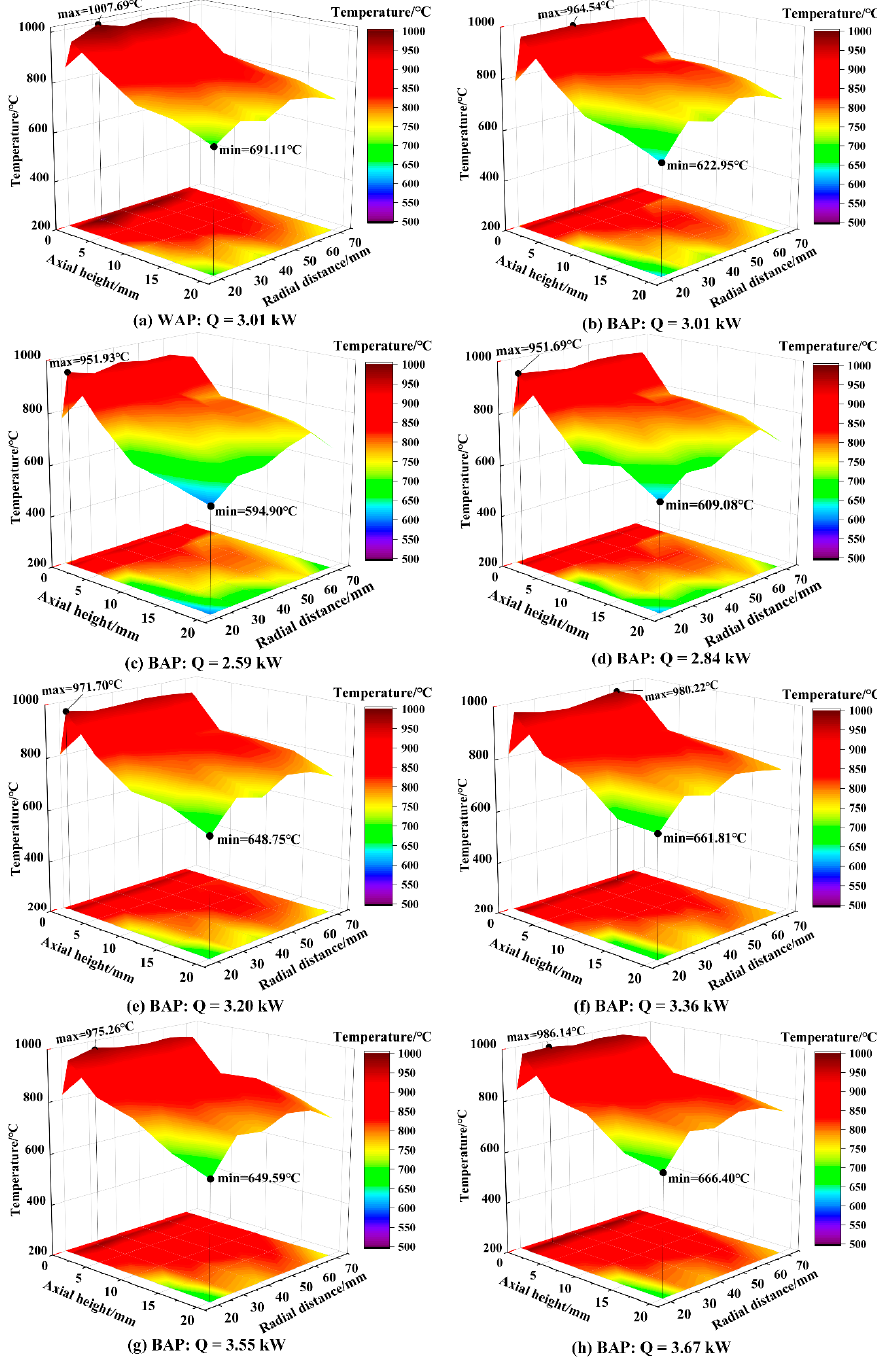
Figure 3. Temperature distribution of the flue gas layer.